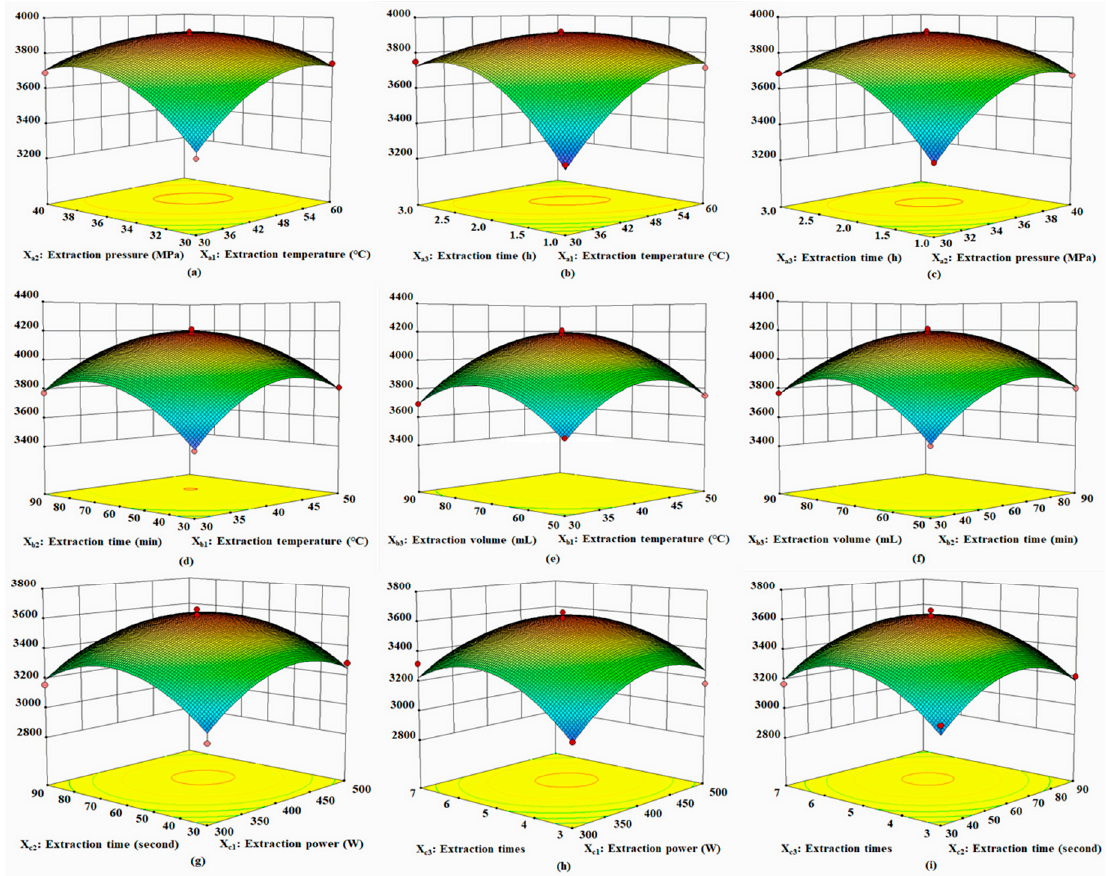
Figure 1. 3D surface plot showing the significant interaction effects of the extraction parameters: ( a – c ) demonstrates the combined effects of SFE; ( d – f ) highlights the combined effects of UAE; ( g – i ) depicts the combined effects of